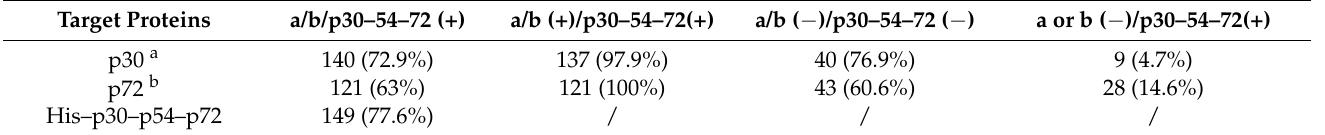
Table 2. Clinical samples from detected by different